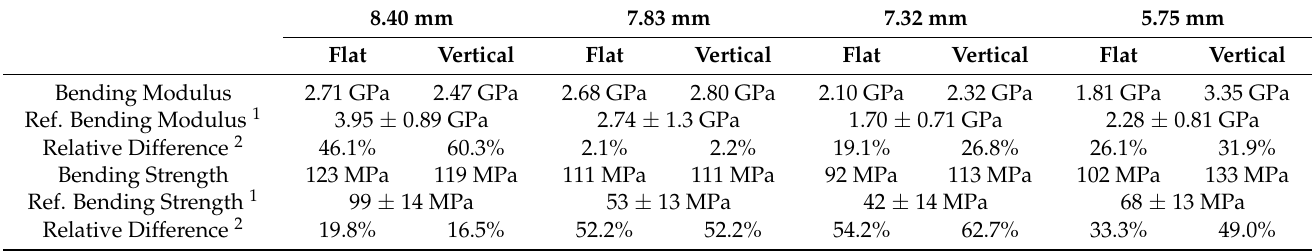
Table 2. Flexural properties of 3D printed samples compared to published results of natural